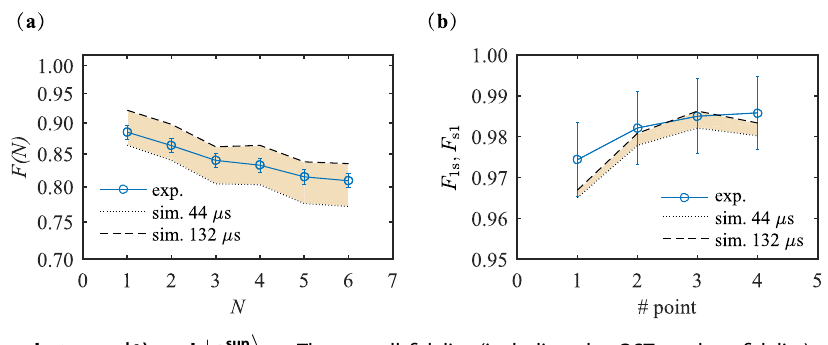
E (cid:1) (cid:1) Fig. 5 Results of transfers between |1 〉 and ψ sup . a The overall fi delity (including the QST readout fi delity) resulting from N transfers tg (cid:1) (cid:3) (cid:1) as a function of N in experiments (blue circles) and simulation (shaded area) in the logarithm scale. b The calculated between |1 〉 and a ψ sup tg transfer fi delity between |1 〉 and |sup 〉 in experiments (blue circles) and simulation (shaded area). Simulations were done at two different coherence times, 44 μ s and 132 μ